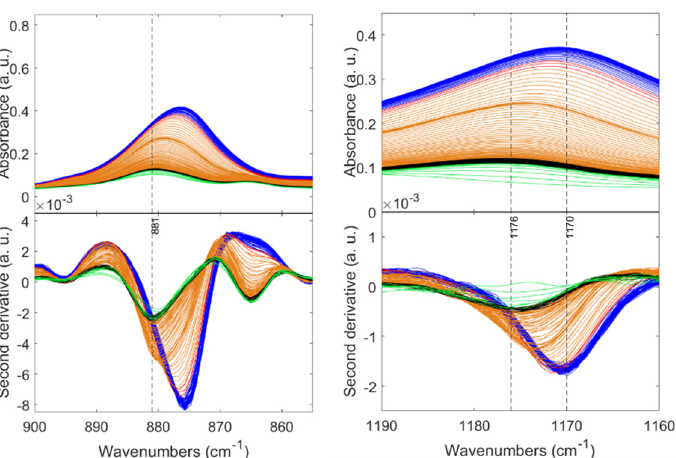
Figure 8. In situ FTIR spectra of the P12E0.2H1.5 solution during the cooling–gelation process (80 °C to RT). For appreciation reasons, the patterns were colored by stages from the beginning to the end: green, black, orange, red, and blue.